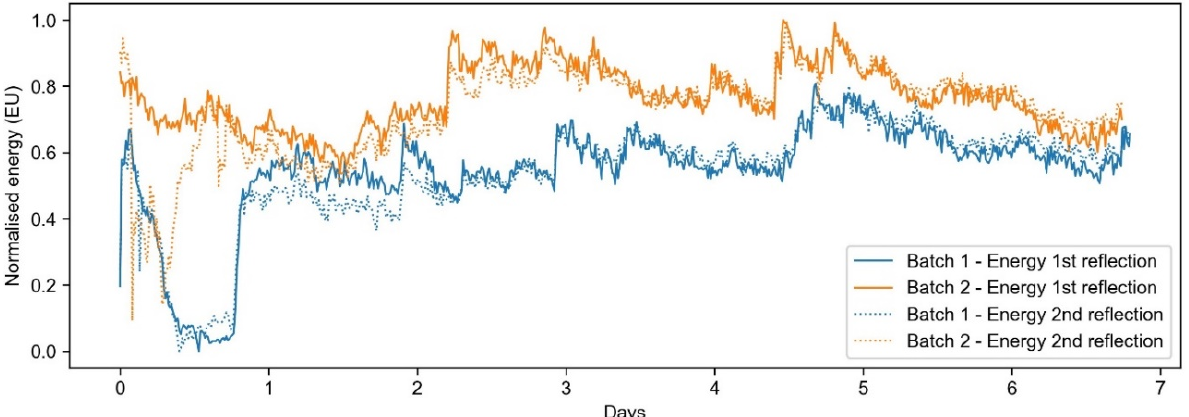
Figure 3. US waveform features for all fermentation batches: ( a ) The energy of the 1st reflection; ( b ) the energy of the 2nd reflection; ( c ) the time of flight for the 2nd reflection; ( d ) the process temperature.